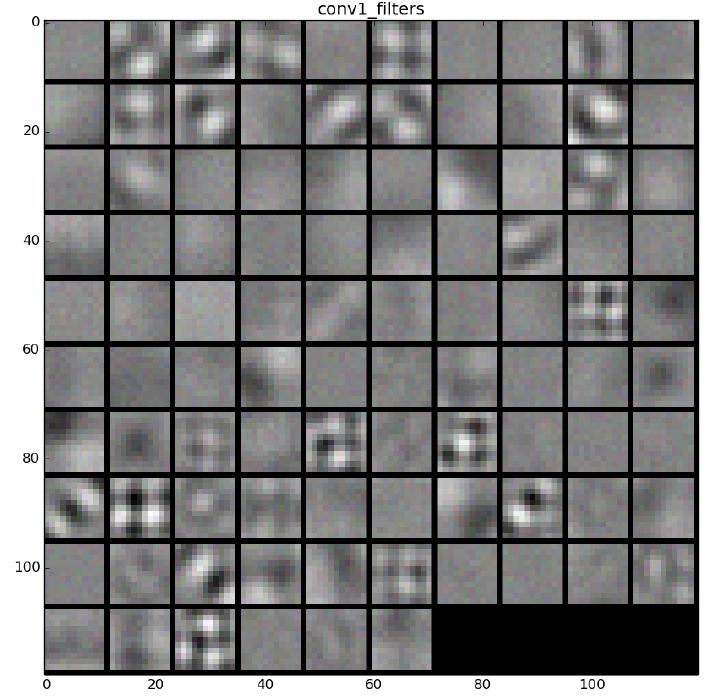
Figure 22. Filters learned in convolution layer